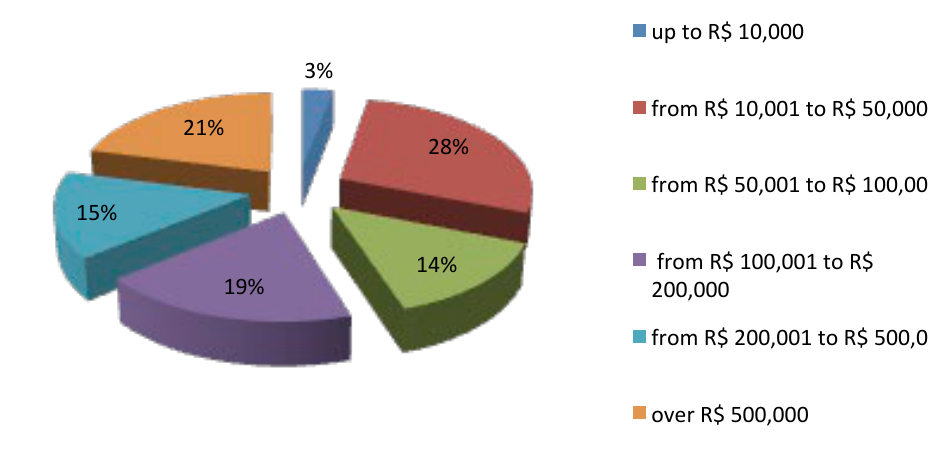
Figure 4. Annual gross income with